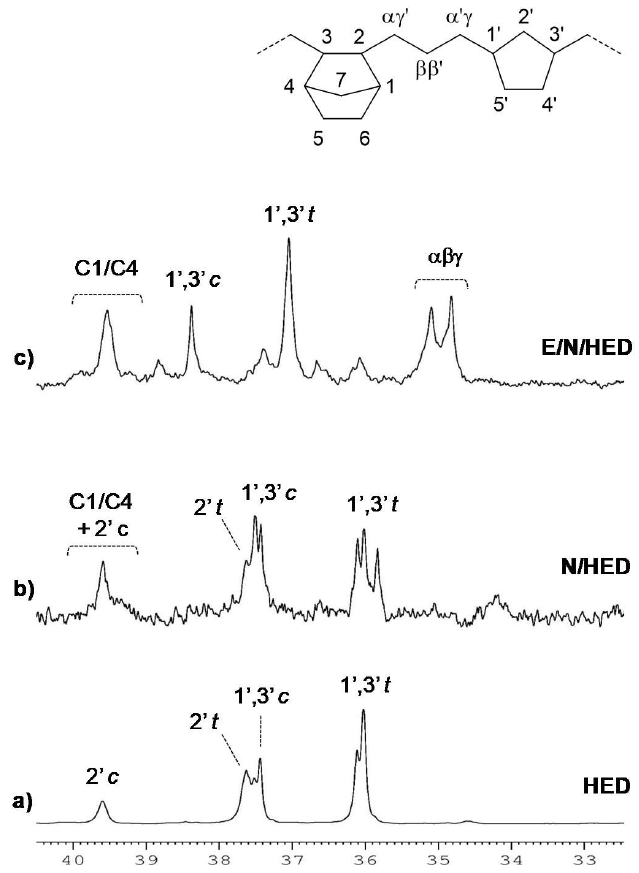
Figure 12. Expansions of the region between 32 and 41 ppm of 13 C NMR spectra (108.58 MHz, C 2 D 2 Cl 4 , 103 °C) of polymers prepared by X/ MAO: ( a ) poly(HED); ( b ) poly(N- co -HED); ( c ) poly(E- ter- N- ter -HED).